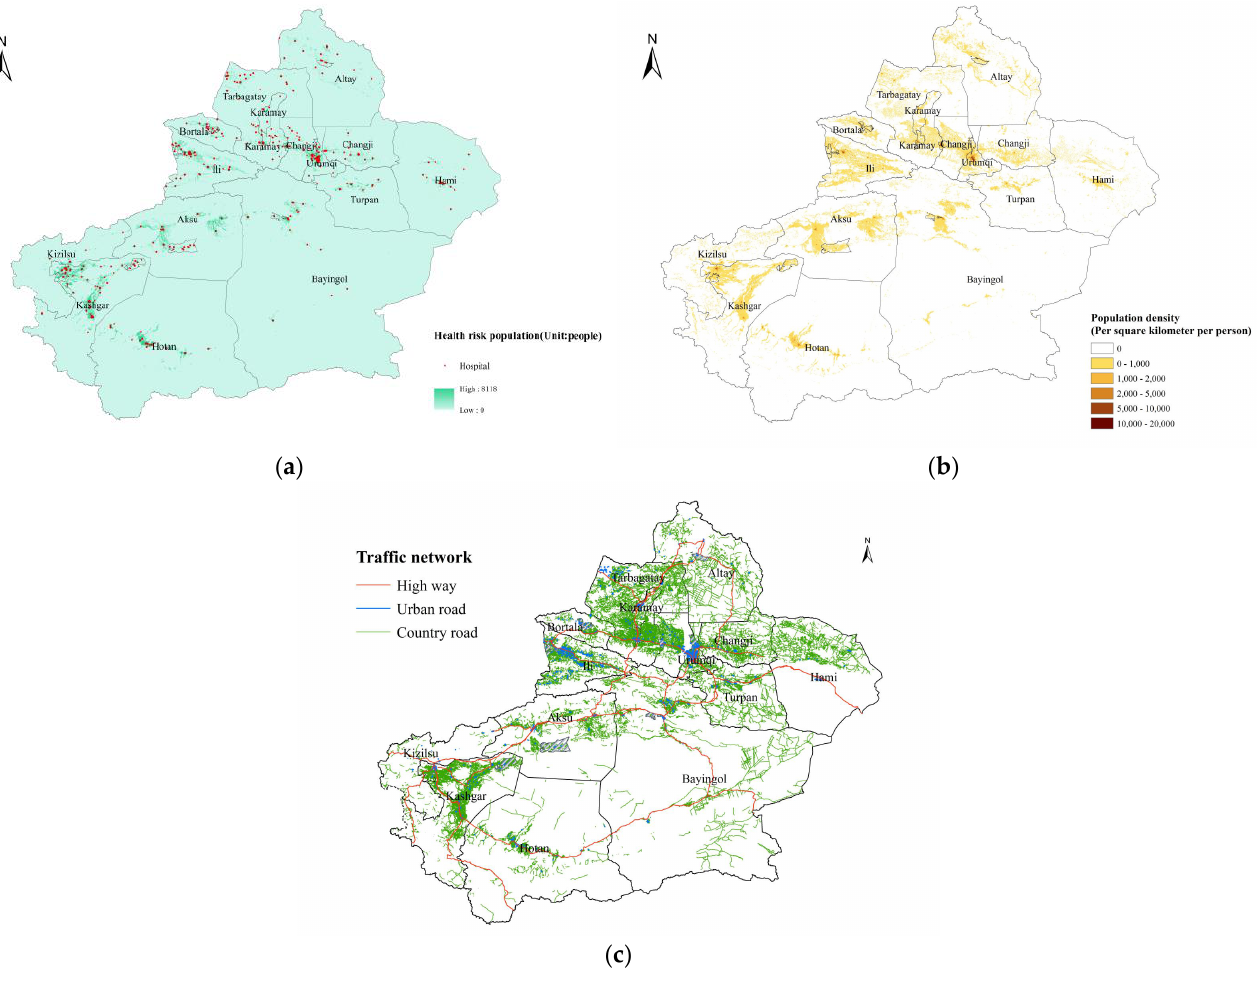
Figure 2. Spatial distributions of population, health risk population, and hospitals: ( a ) spatial distribution of health risk population and hospitals; ( b ) spatial distribution of population; ( c ) Xinjiang Oasis Regional Geographical Conditions Monitoring road network